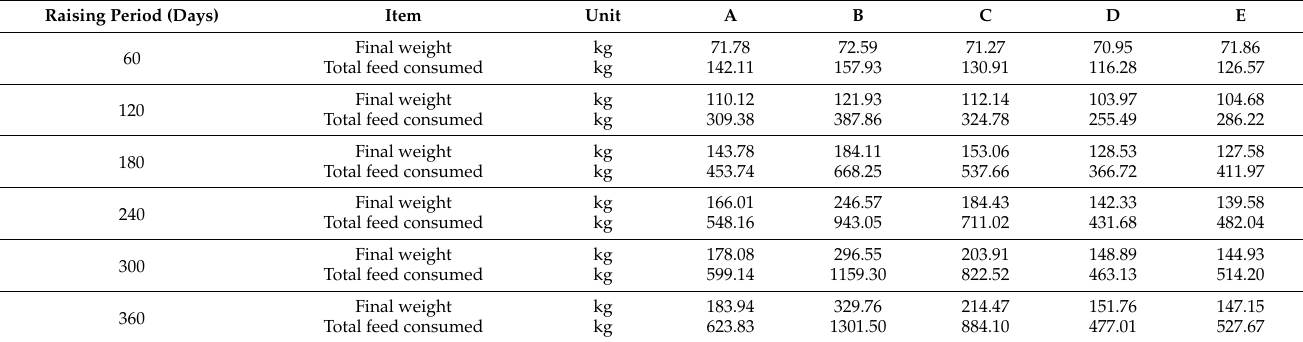
Table 4. Details of Wt and CFI.